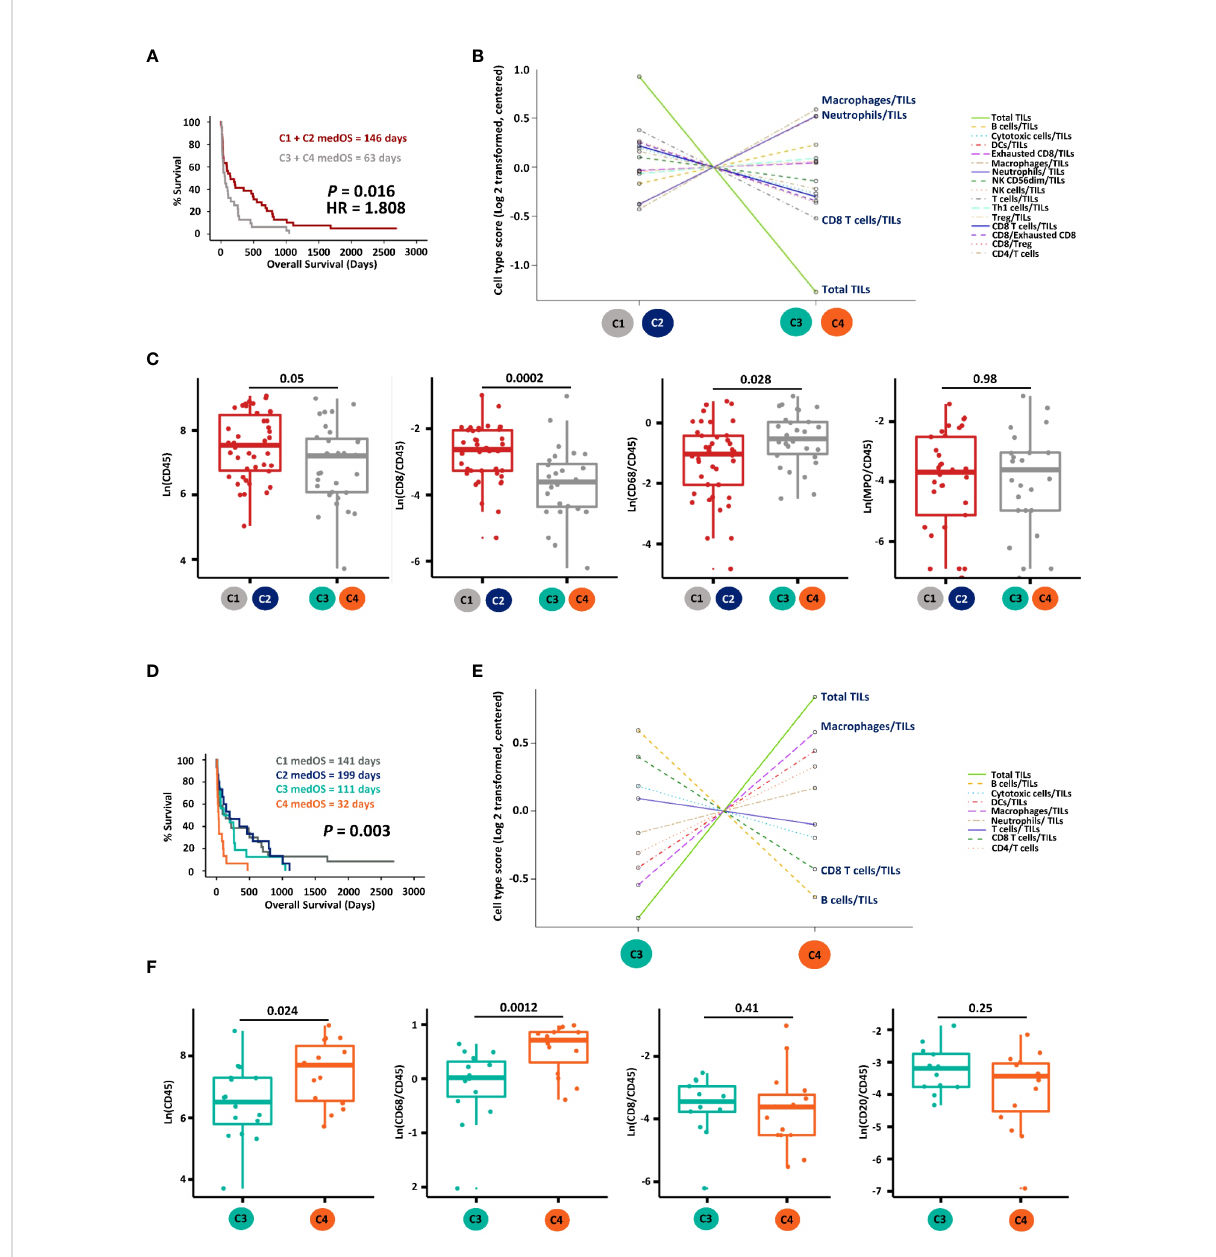
FIGURE 2 Prognostic and immune cell composition analyses of the four gene clusters. (A) Kaplan-Meier survival analysis of hot (cluster C1 + C2) versus cold (cluster C3 + C4) MPE LADC patients. (B) Immune cell type score comparison between hot and cold MPE LADC tumours on mRNA level. (C) Immune cell component comparison between hot and cold MPE LADC tumours according to IHC quanti fi cations. Immune cell markers with the highest two (macrophages/TILs and neutrophils/TILs) and lowest two (CD8 T cells/TILs and total TILs) immune cell type scores were selected for IHC validation. (D) Kaplan-Meier survival analysis of all patient clusters (C1 to C4). (E) Immune cell type comparison of gene clusters C3 versus C4 on mRNA level. (F) Immune cell type comparison of gene clusters C3 versus C4 according to IHC quanti fi cations. Immune cells markers with the highest two (macrophages/TILs and total TILs) and lowest two (CD8 T cells/TILs and B cells/TILs) scores were selected for IHC validation. For Kaplan-Meier survival analysis, the p-value (P) of log-rank tests is indicated. medOS, median overall survival; TILs, tumour in fi ltrating